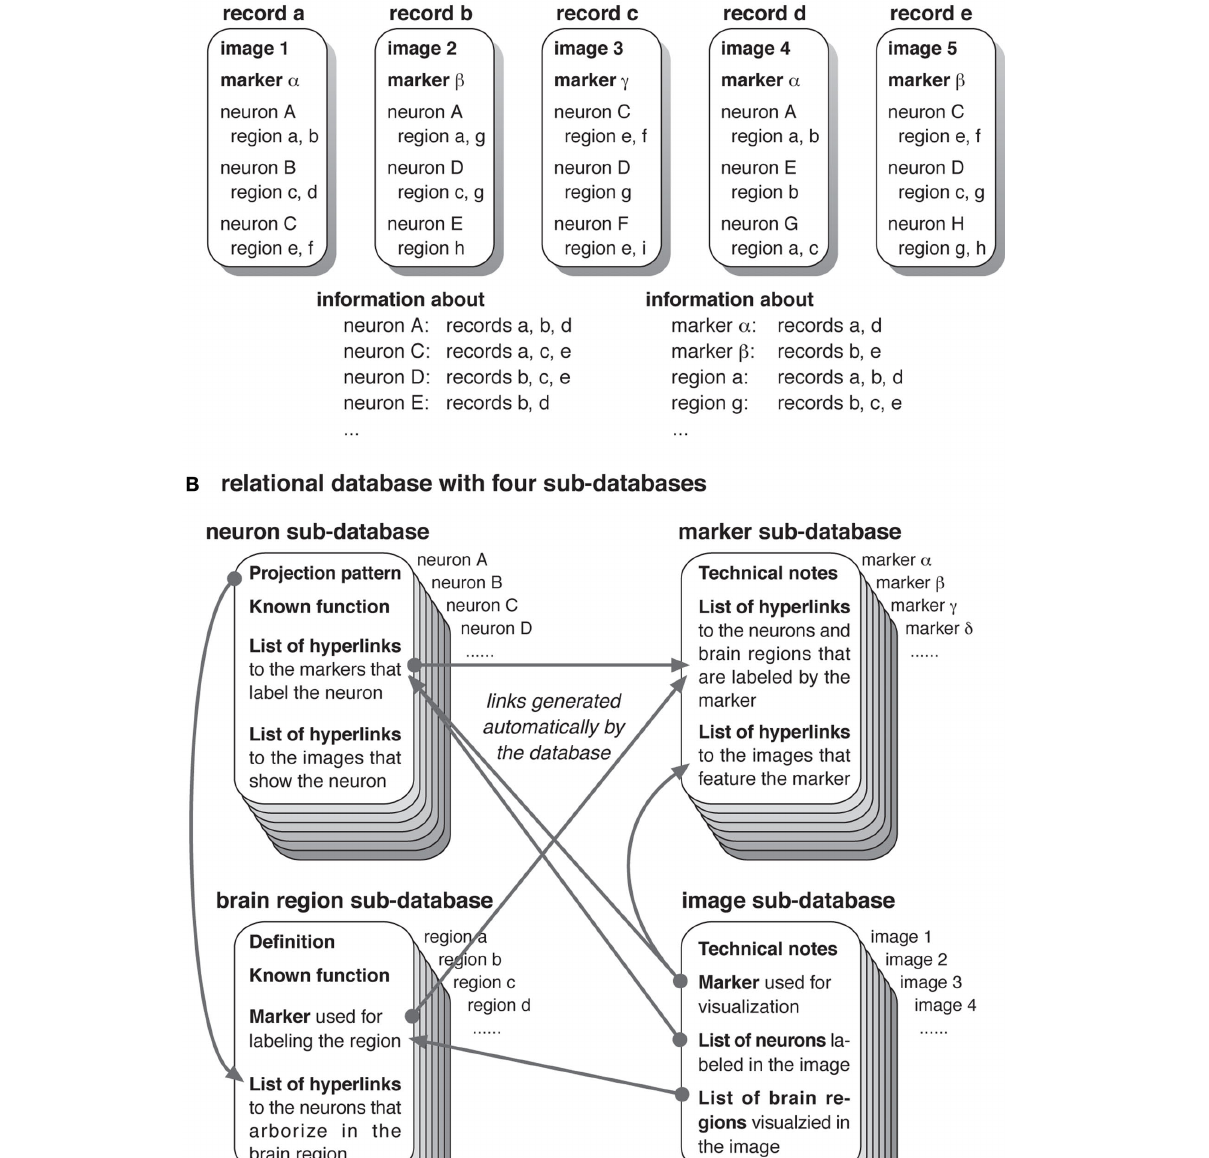
FigurE 2 | composition of the records for ensuring consistency. (a) A schematic example of a typical image database. Each record presents an image, or a set of images, visualizing particular groups of neurons with a particular molecular marker, showing particular regions of the brain. Different images may visualize the same neuron type with different combinations, and the same molecular marker is used for visualizing multiple types of neurons. As each record describes particular area of the brain, only a subset of the arborization targets of a neuron may be mentioned. Thus, description of a specific neuron